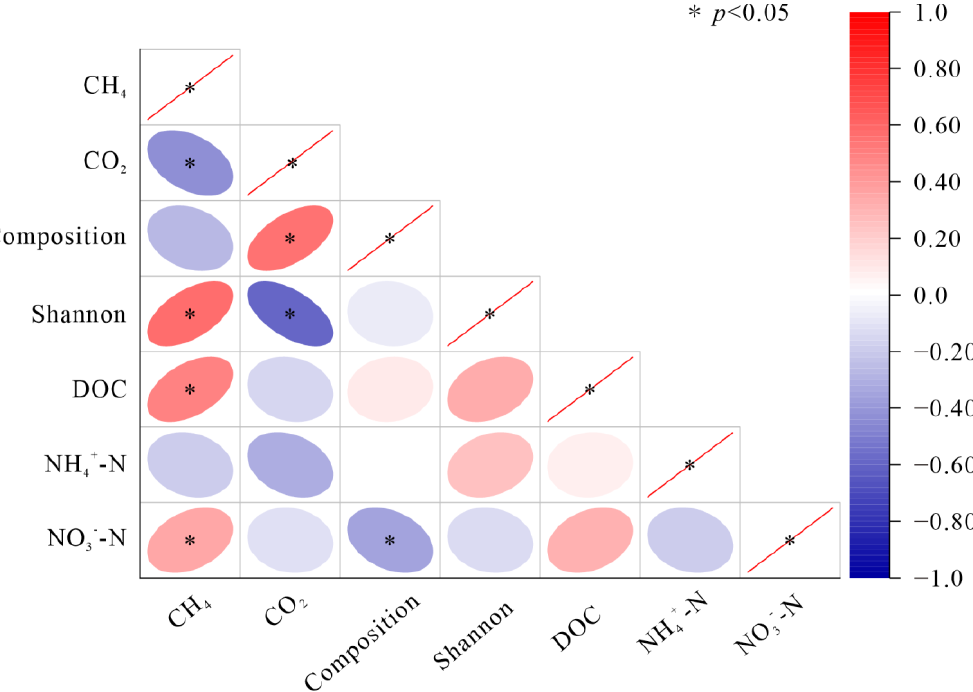
Figure 9. Pearson correlations among soil carbon emissions, bacterial diversity, and substrates after incubation. Red indicates positive correlations, and blue indicates negative correlations. * indicates significant correlations at the 0.05 level. Table 2. The biological and abiotic factors related to CO 2 and CH 4 emission rates in forest and wet- land patches.